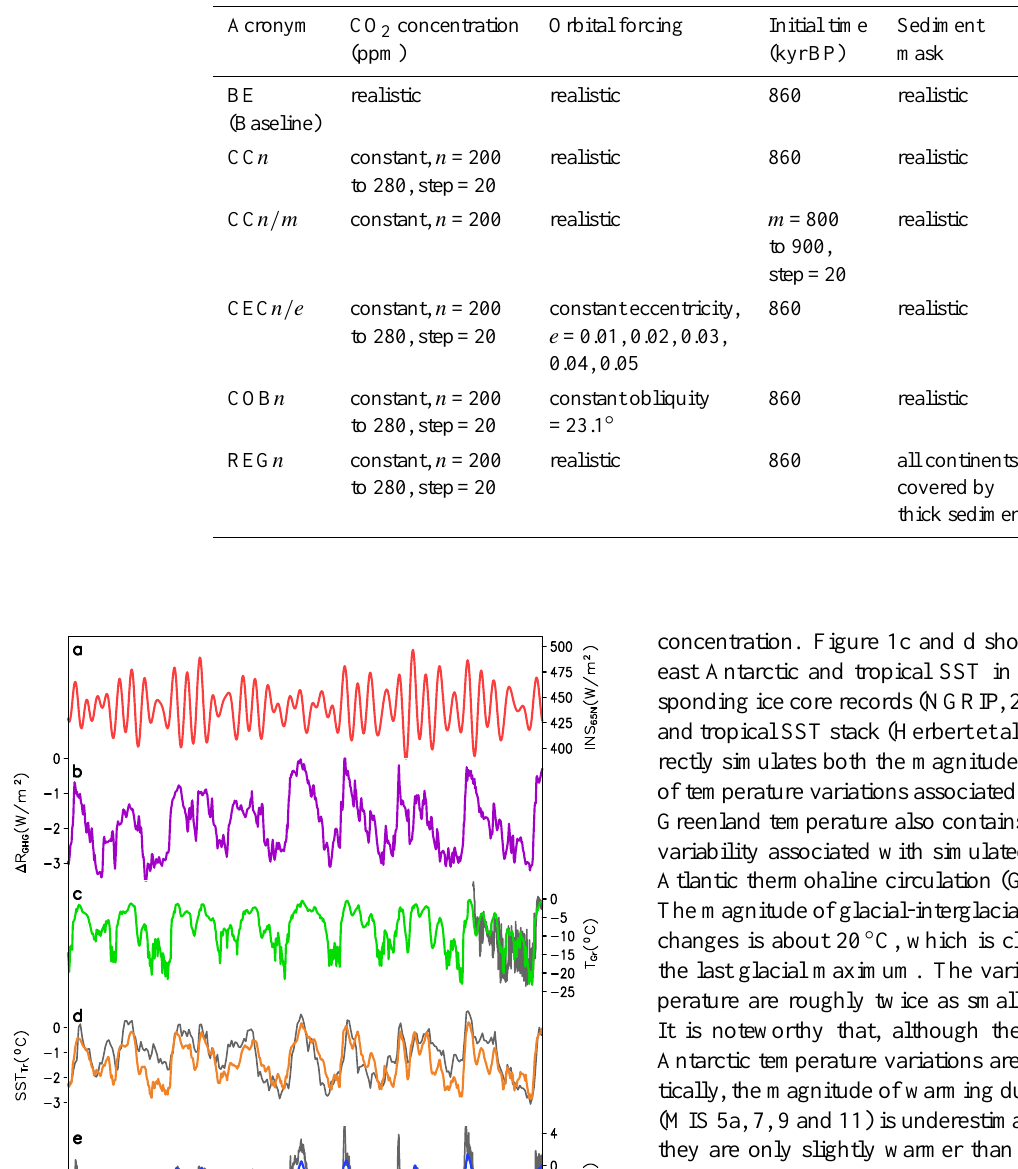
Table 1. List of model experiments.